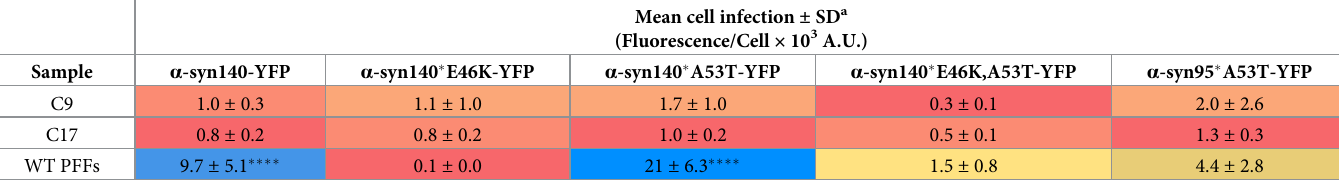
a Colors represent heat map of infectivity with blue indicating high infectivity for a given cell line and red indicating low infectivity for a given cell line. ���� = P < 0.0001 compared to control-patient samples C9 and